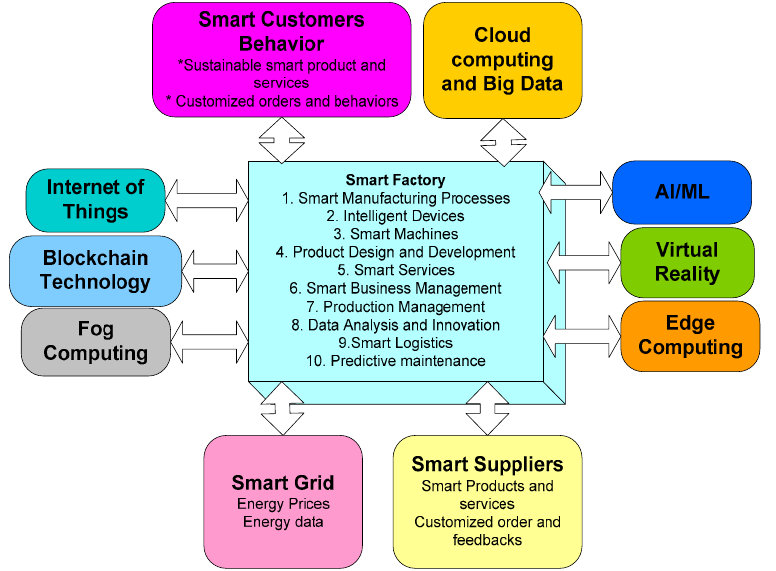
Figure 1. Architecture of smart factory in Industry 4.0 [5].